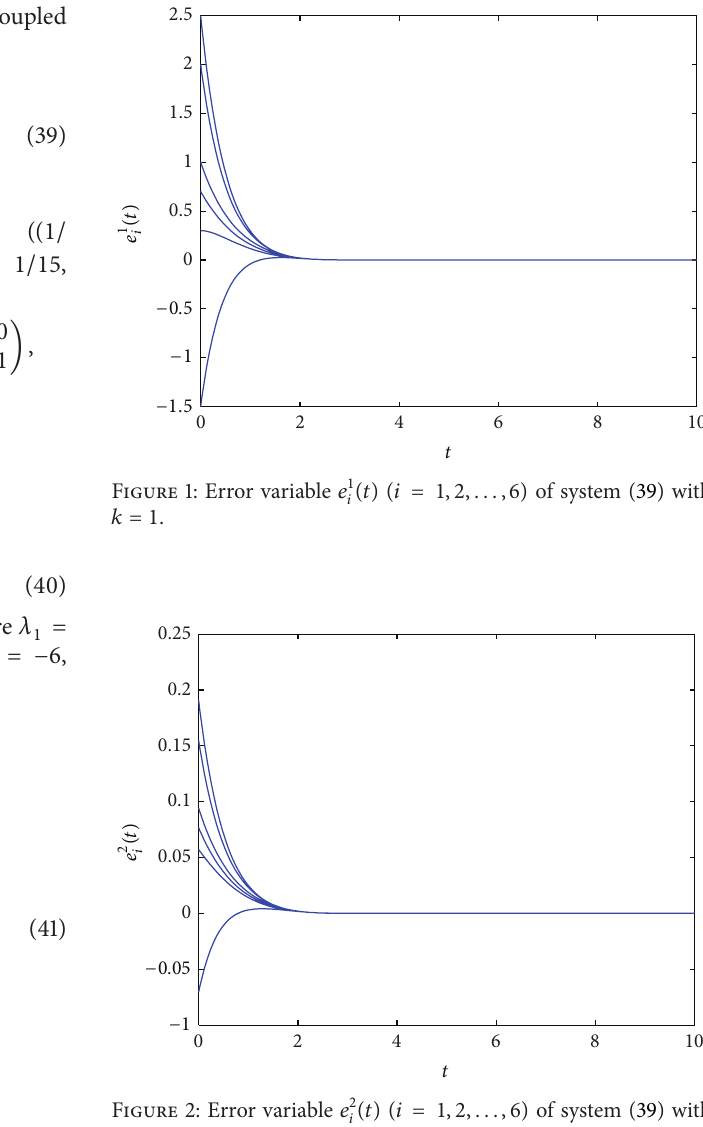
Figure 2: Error variable 𝑒 2 𝑖 (𝑡) (𝑖 = 1, 2, . . . , 6) of system (39) with 𝑘 = 1